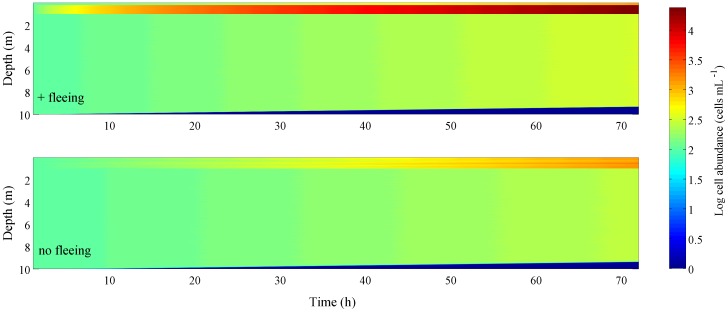
Effect of predator-induced fleeing behaviors on phytoplankton bloom formation.Predictions of phytoplankton abundance and distribution in a spatially explicit model that does (top) and does not (bottom) include empirically observed phytoplankton avoidance of predator inhabited, deeper waters. All parameters, including growth rates were empirically measured and, with the exception of fleeing behaviors, identical in all model runs.